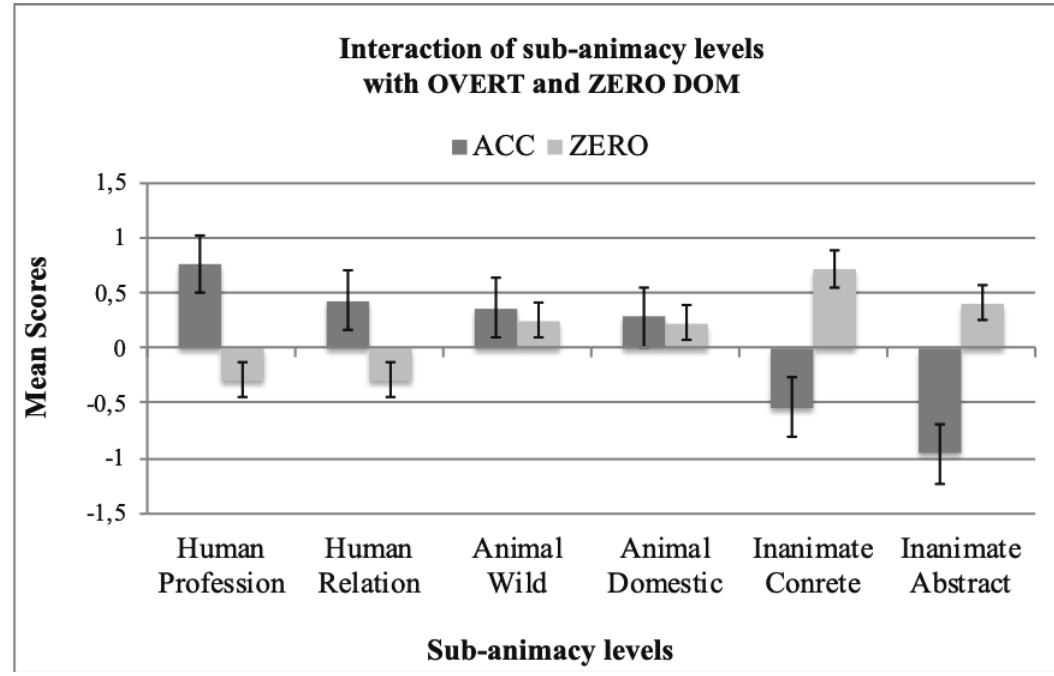
Figure 5. Acceptability of sentences with indefinite direct objects belonging to different sub-animacy levels with overt and zero DOM marking used in transparent context. Error bars represent +/- 2 standard errors